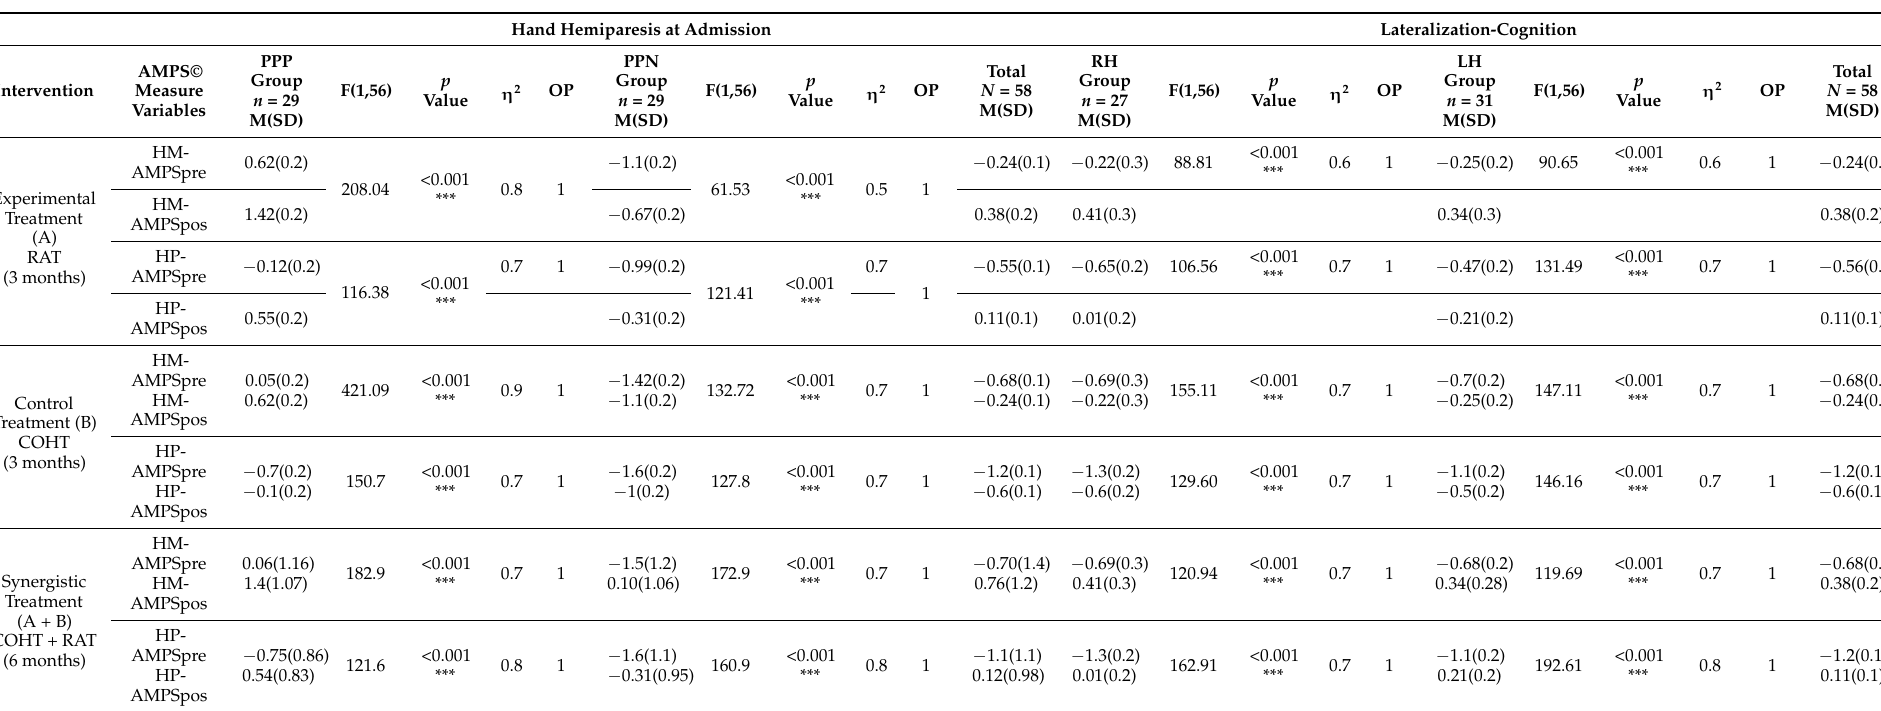
Table 3. ADL functional effects of COHT /RAT treatments at 3 and 6 months by both prognosis (PPP, PPN) and lateralization-cognition groups (RH, LH). Hand Hemiparesis at Admission